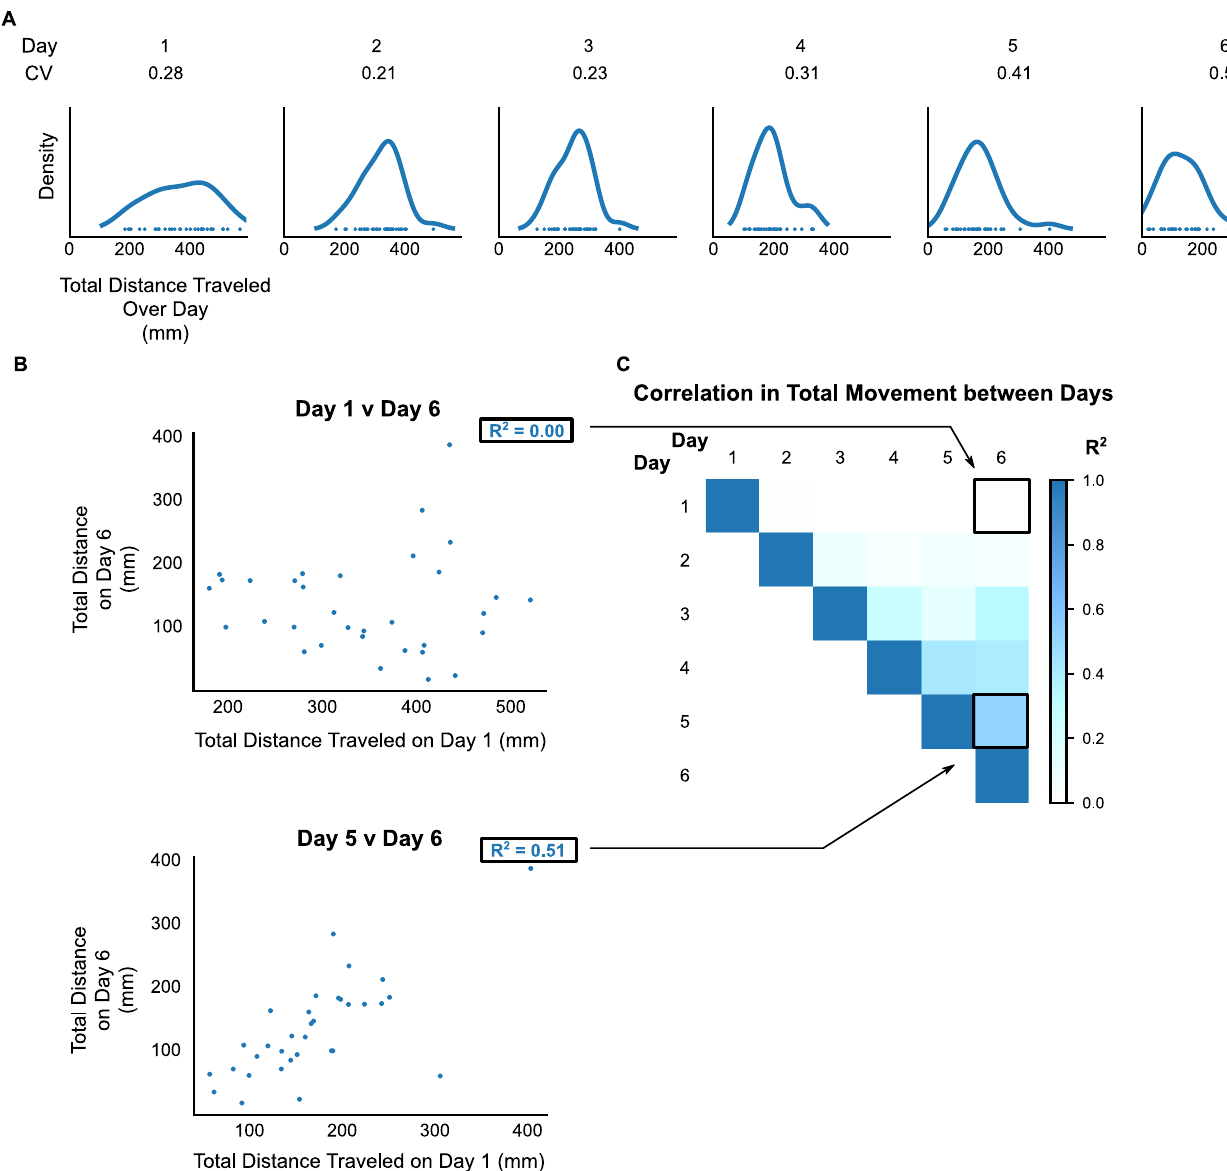
Fig 4. Interindividual variability and persistence of movement activity throughout early-adult life. (A) Distribution of total movement on each day of the first 6 days of adulthood across all observed individuals. The population is depicted as a kernel density histogram with each dot at the bottom of the histogram representing a single individual’s movement for the day. Variability in movement on a given day is quantified as coefficient of variation (CV) and shown above each histogram. (B) Scatter plot demonstrating degree of correlation between an individual’s first- ( top panel ) or fifth-day ( bottom panel ) movement and its movement on the sixth/last day of observation. Correlation noted as Pearson-product linear R 2 . (C) Heatmap of pair-wise correlations in movement between all days of observation. Entries corresponding to each panel in (B) depicted by arrows.